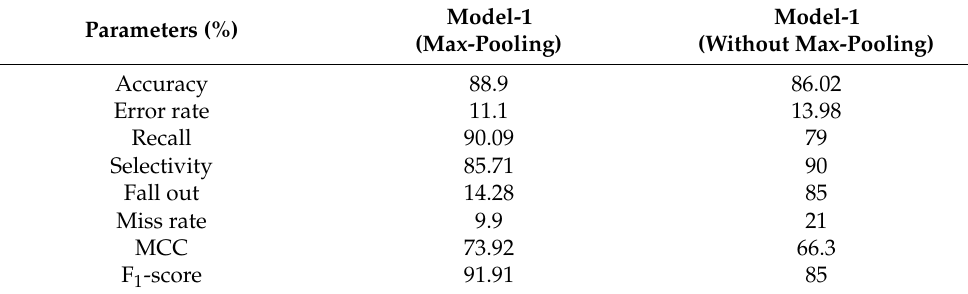
Table 2. Performance Evaluation of Proposed CNN Model-1.